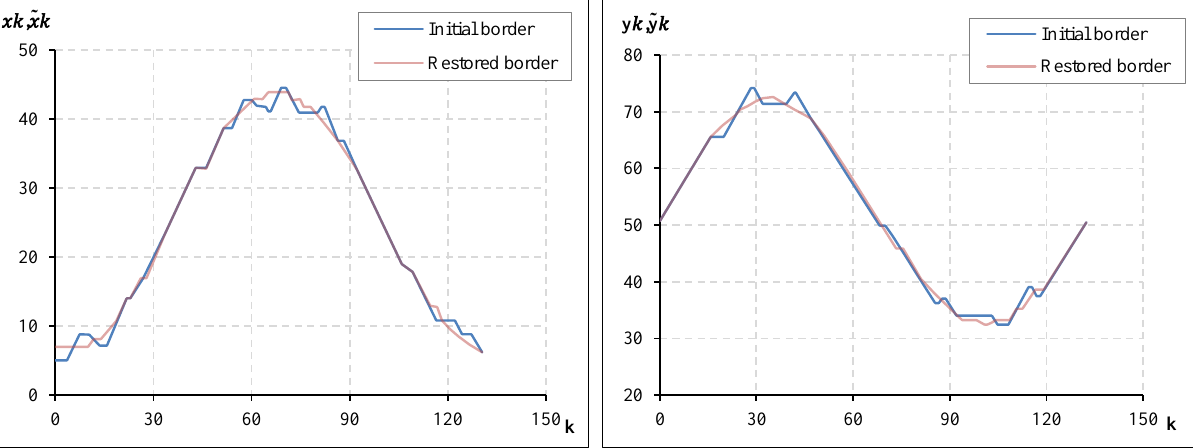
Figure 16. Parametric curves of the initial and restored contour boundary By performing inverse Fourier transforms concerning the modified contour spectrum and comparing it with the initial contour, it is possible to achieve a minimum number of analyzed descriptors, which is the primary goal of the proposed technique. Restoring the contour boundaries of the segment of interest requires using the fundamental reversibility of the Fourier transform; thus, Equation 22 can be applied. Therefore, whatever the number of counts present on the contour, the same number of descriptors will be required for its restoration. It is possible to simplify the decision models considerably when some descriptors have zero